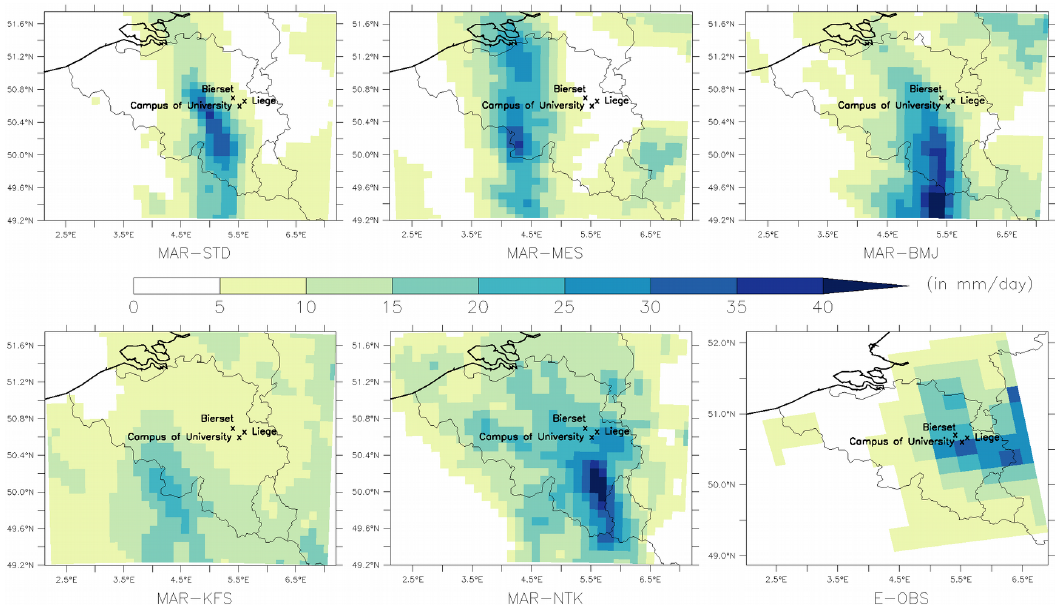
Figure A1. Precipitation simulated by MAR for each experiment and provided by E-OBS on the 29 May 2008 (in mm/day).